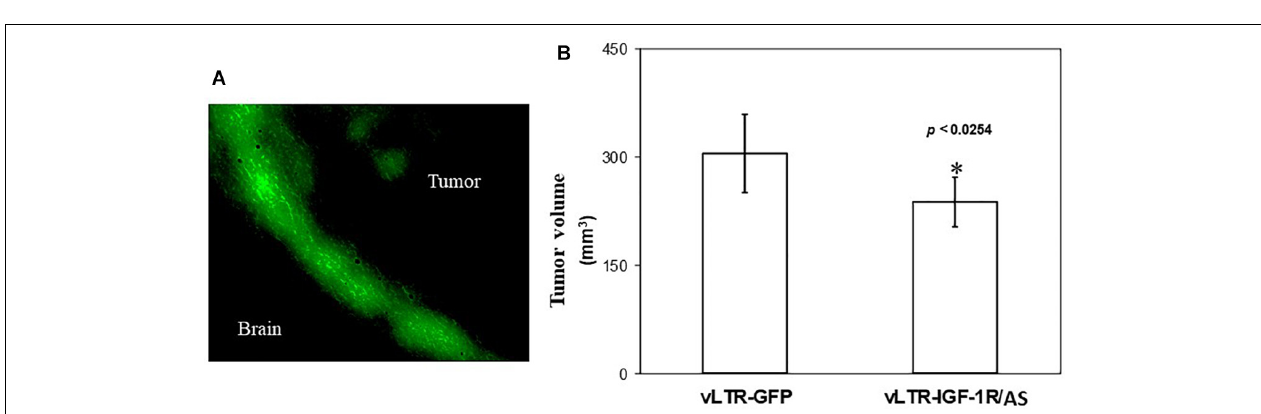
FIGURE 5 | In vivo targeting of pre-implanted rat glioma cells with IGF-IR antisense expressing viral particles reduces tumor expansion. Shown in (A) are intra-cerebral C6 cells following in vivo transduction with vLTR-GFP retroviral particles. GFP-expressing cells were observed mainly at the expanding edge of the tumors. Shown in (B) are mean tumor volumes ( ± SD) following two injections of vLTR-IGF-IR AS or control vLTR-GFP particles, 6 and 13 days post orthotopic implantation of C6/LacZ cells ( n = 5, ∗ p <